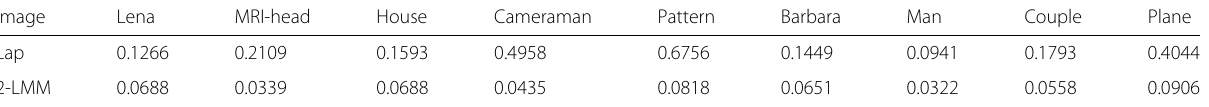
Table 1 The Kullback-Leibler divergence of the best fitting probability models and the empirical probability density function are computed for the two